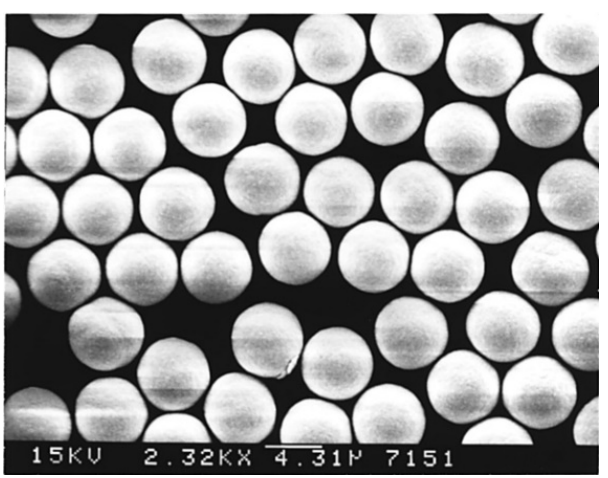
Figure 1. SEM image of poly(DVB-55) microspheres with porous shells prepared in a toluene/acetonitrile (40/60) mixture. Reprinted with permission from Ref. [16]. Copyright 2000 American Chemical Society.